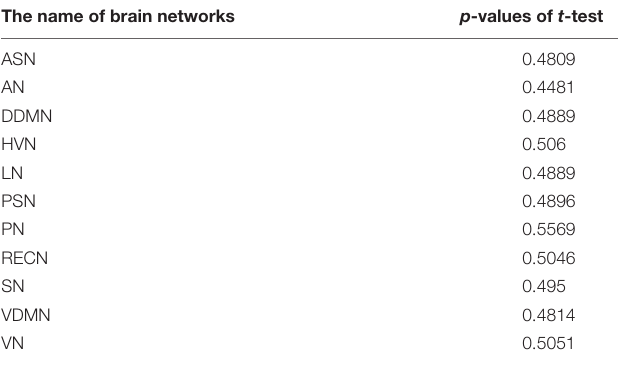
TABLE 2 | The p -values of the components are shown in the